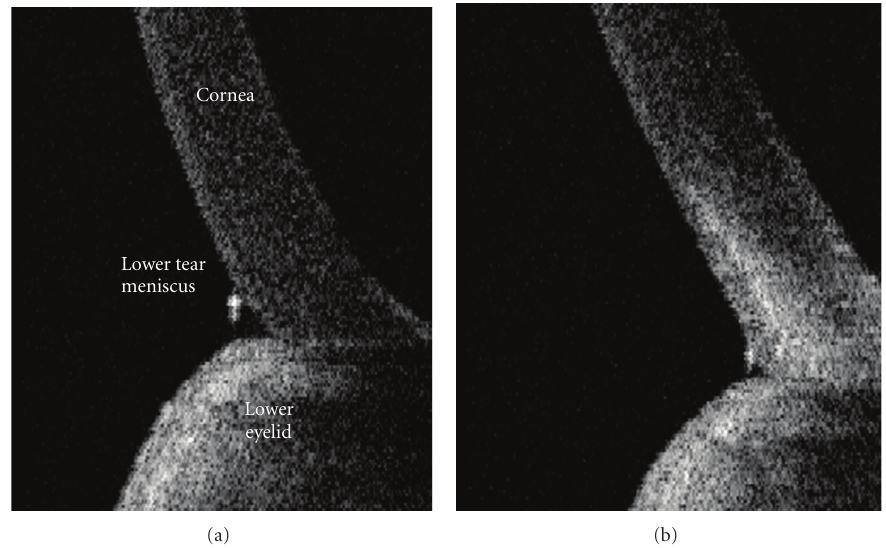
Figure 1: For each subject, a series of vertical cross-sectional images of the lower tear meniscus were taken with OCT. Analysis was done of the height and area of the triangular region at the junction of the cornea and lower lid. Representative OCT images (a) before and (b) after airflow